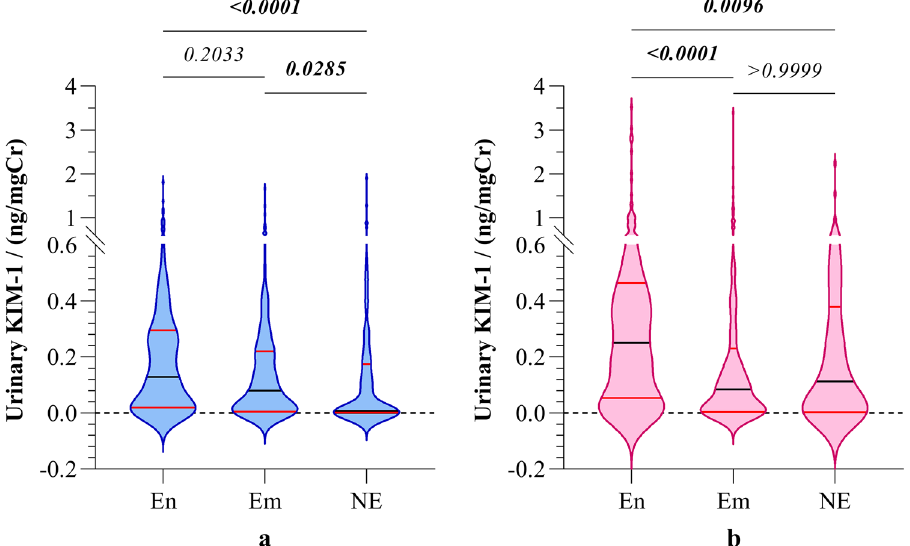
Figure 3. Gender-stratified distribution of urinary KIM-1 in ( a ) boys and ( b ) girls from CKDu endemic, emerging, and non-endemic regions. Graphs illustrate the median and interquartile range. Inter-group comparison is expressed in terms of Kruskal–Wallis one-way analysis followed by Dunn’s multiple comparison test. The study groups: En: endemic, Em: emerging, and NE: non-endemic regions. KIM-1: Kidney injury molecule-1.